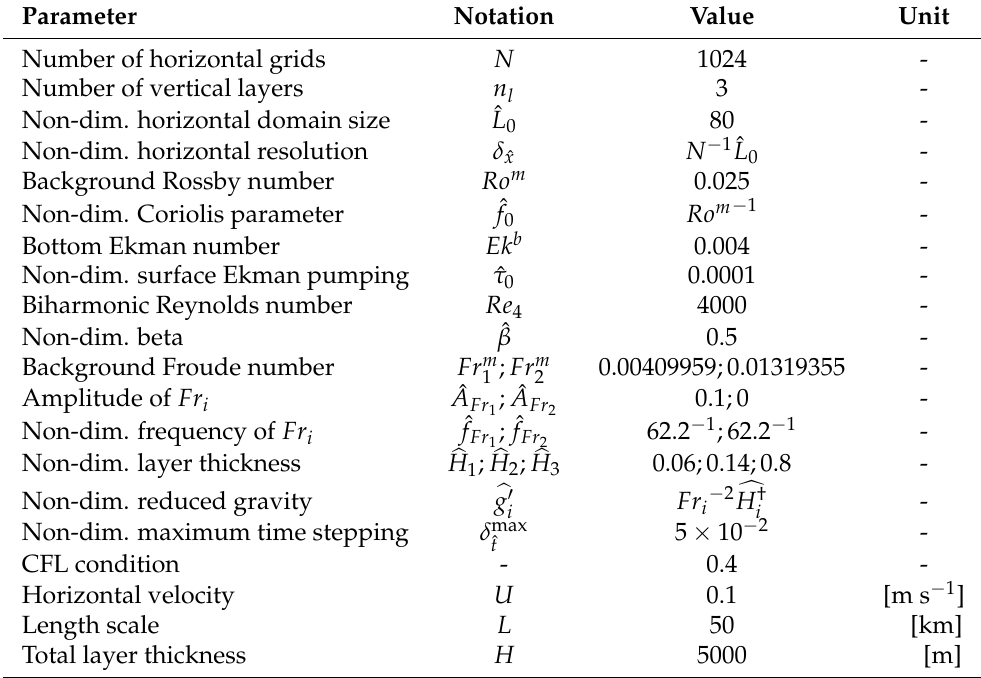
Table 1. Parameters used to configure the three-layer QG simulation and dimensionalized charac- teristic scales. The bottom Ekman number is the ratio between the bottom Ekman-layer thickness and (cid:98) H 3 and bottom friction is (cid:101) = Ek b / ( 2 Ro m (cid:98) H 3 ) . Beta is dimensionalized as β = ˆ β U / L 2 and the dimensionalized domain size is 4000 km ( =ˆ L 0 L ) . The frequency of Fr translates approximately to a L / U ). The prognostic time stepping is determined via the CFL condition within 360-day year (= f − 1 Fr values smaller than δ max ˆ t